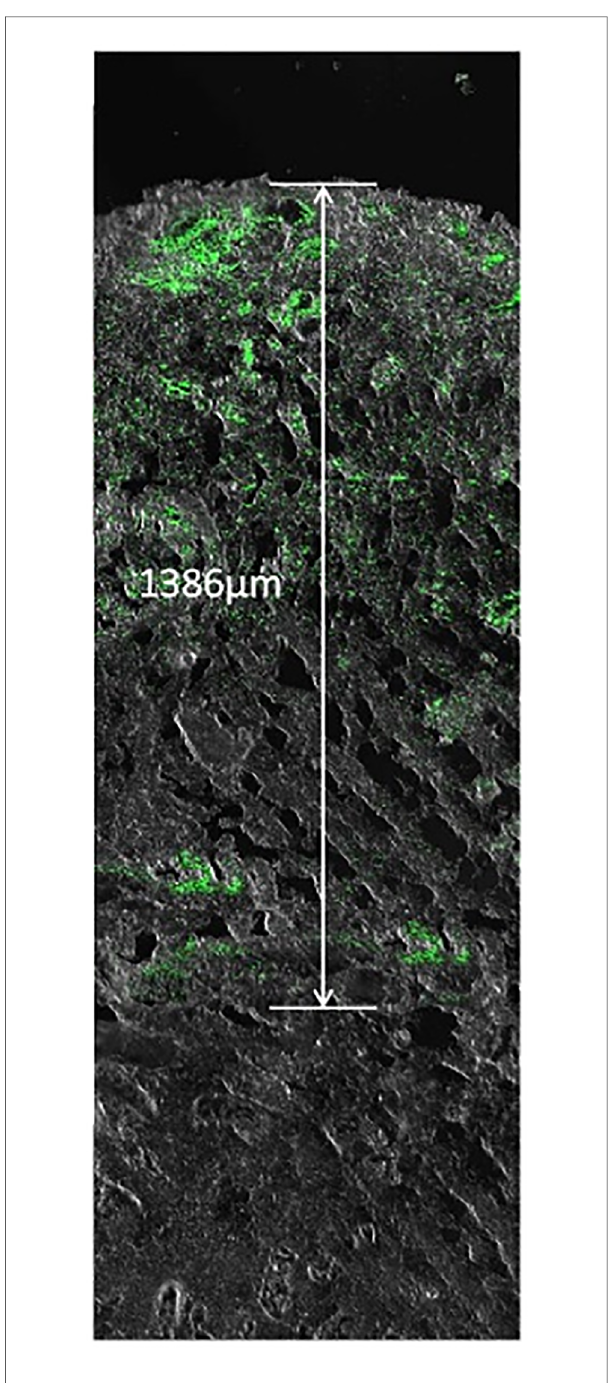
FIGURE 1 The depths of the bacterial fl uorescent signal from